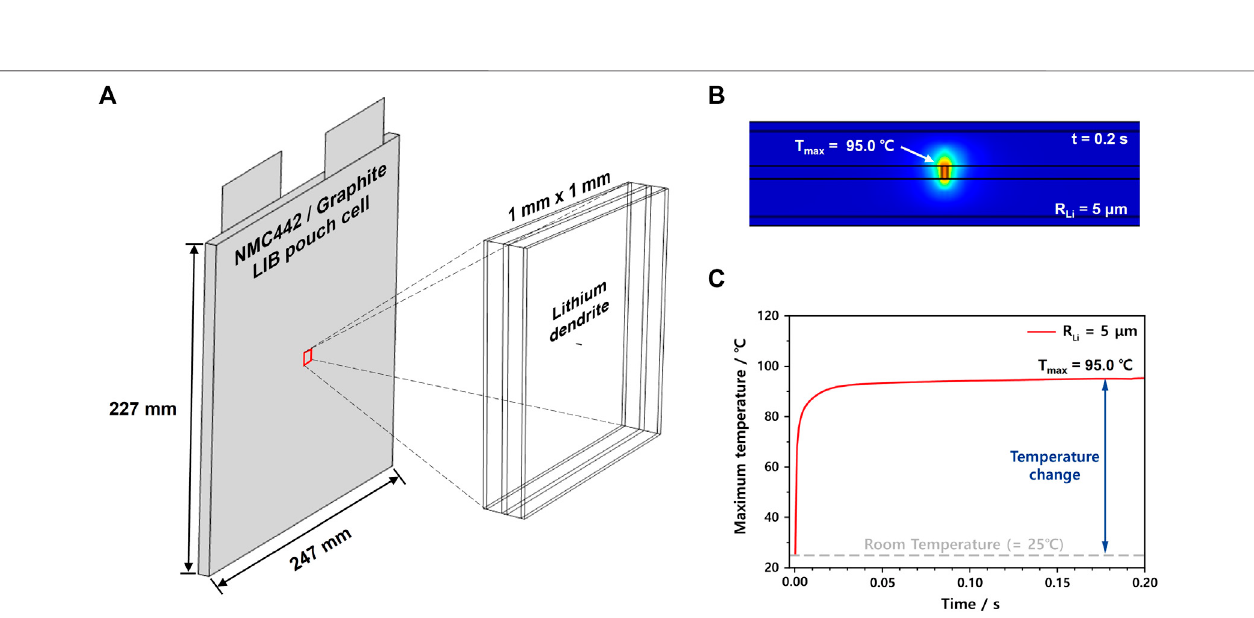
( Supplementary Table S3 ), the 3D electrochemical-thermal model for simulating the ISC was developed using COMSOL Multiphysics 5.5. This model is designed to simulate the ISC between two electrodes induced by the formation of